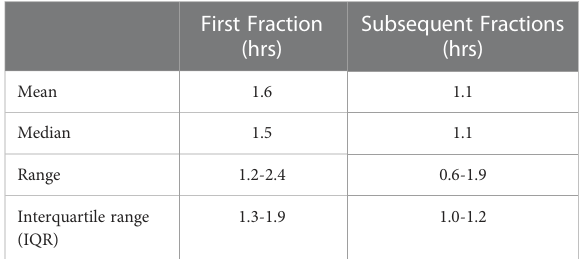
TABLE 1 Statistics of treatment times for patients treated with VMAT